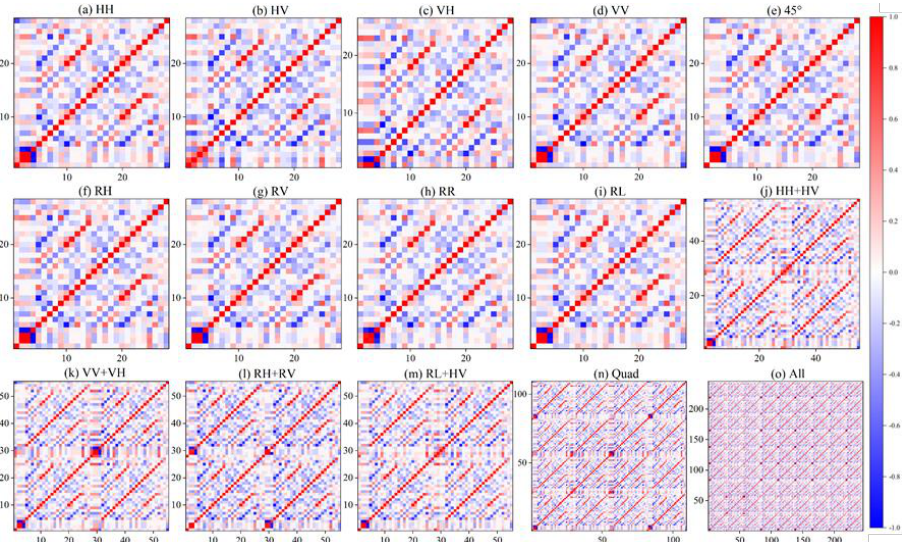
Figure 6. Color-coded correlation coefficient matrices for the features in different polarization mod- els of ( a ) HH, ( b ) HV, ( c ) VV, ( d ) VH, ( e ) 45° linearly, ( f ) RH, ( g ) RV, ( h ) RR, ( i ) RL, ( j ) HH + HV, ( k ) VV + VH, ( l ) RH + RV, ( m ) RL + HV, ( n ) Quad, ( o )